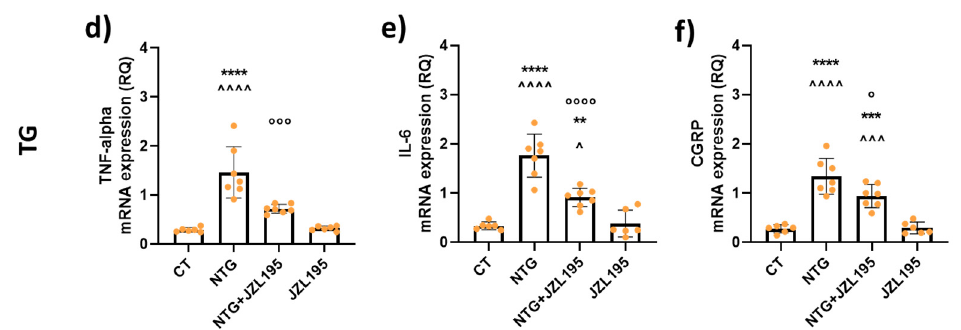
Figure 6. Cytokine gene expression levels in cervical spinal cord (CSC) and trigeminal ganglion (TG) ipsilateral to formalin injection. Male Sprague–Dawley rats were treated with JZL195 at a dose of 3 mg/kg (i.p.) dissolved in a volume of 2 mL/kg of vehicle (Tween-80/polyethylene glycol 200/saline). Rats underwent the orofacial formalin test 4 h after NTG and vehicle injection. All animals were sacrificed at the end of the formalin test to evaluate mRNA expression levels in peripheral and central areas. TNF-alpha ( a , d ), IL-6 ( b , e ), and CGRP ( c , f ) mRNA levels are expressed as relative quantification (RQ). Data are expressed as mean ± SD. One-way ANOVA followed by Tukey’s multiple comparisons test; ** p < 0.01, *** p < 0.001, and **** p < 0.0001 vs. CT; ˆ p < 0.05, ˆˆ p < 0.01,